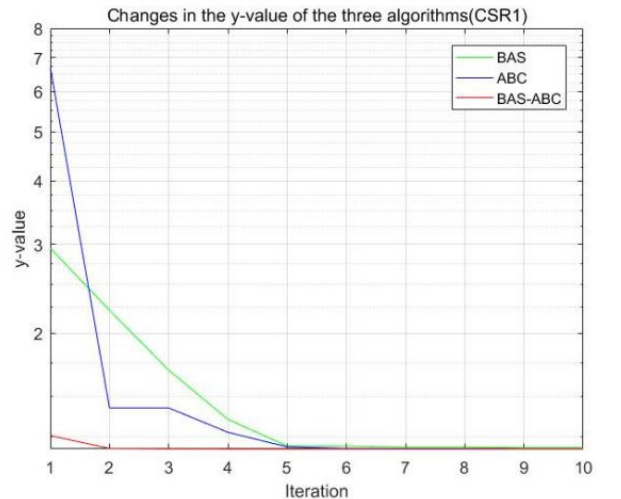
Figure 10. Changes in the 𝑦 value of the three algorithms (CSR1).